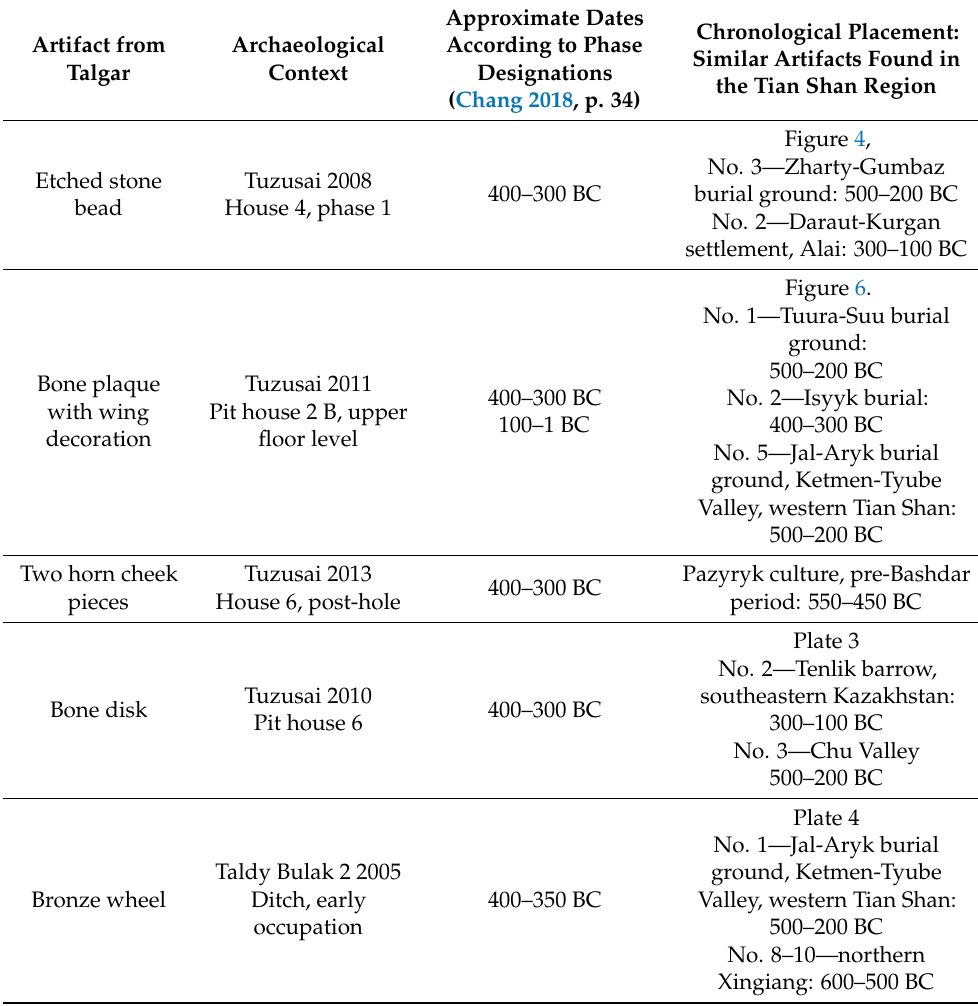
Table 2. Archaeological context, phase dating, and chronological placement according to comparative analogies in the Tian Shan region and regions with close